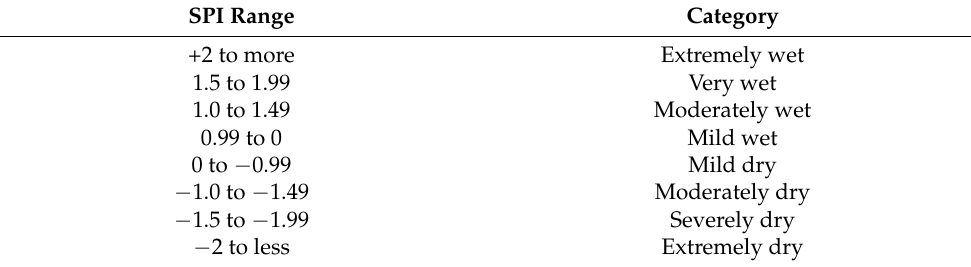
Table 2. SPI range and its